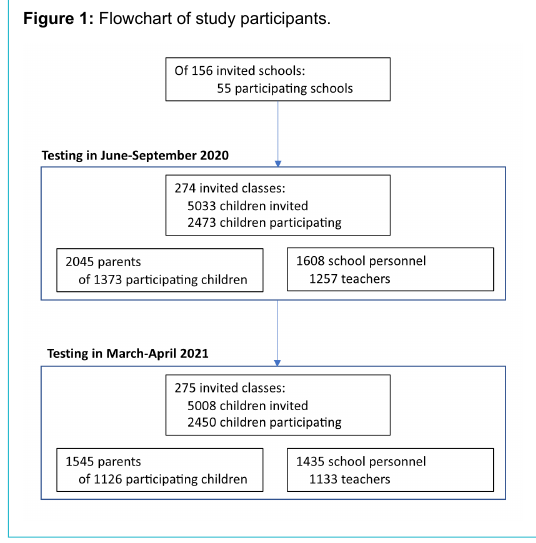
Figure 1: Flowchart of study participants.